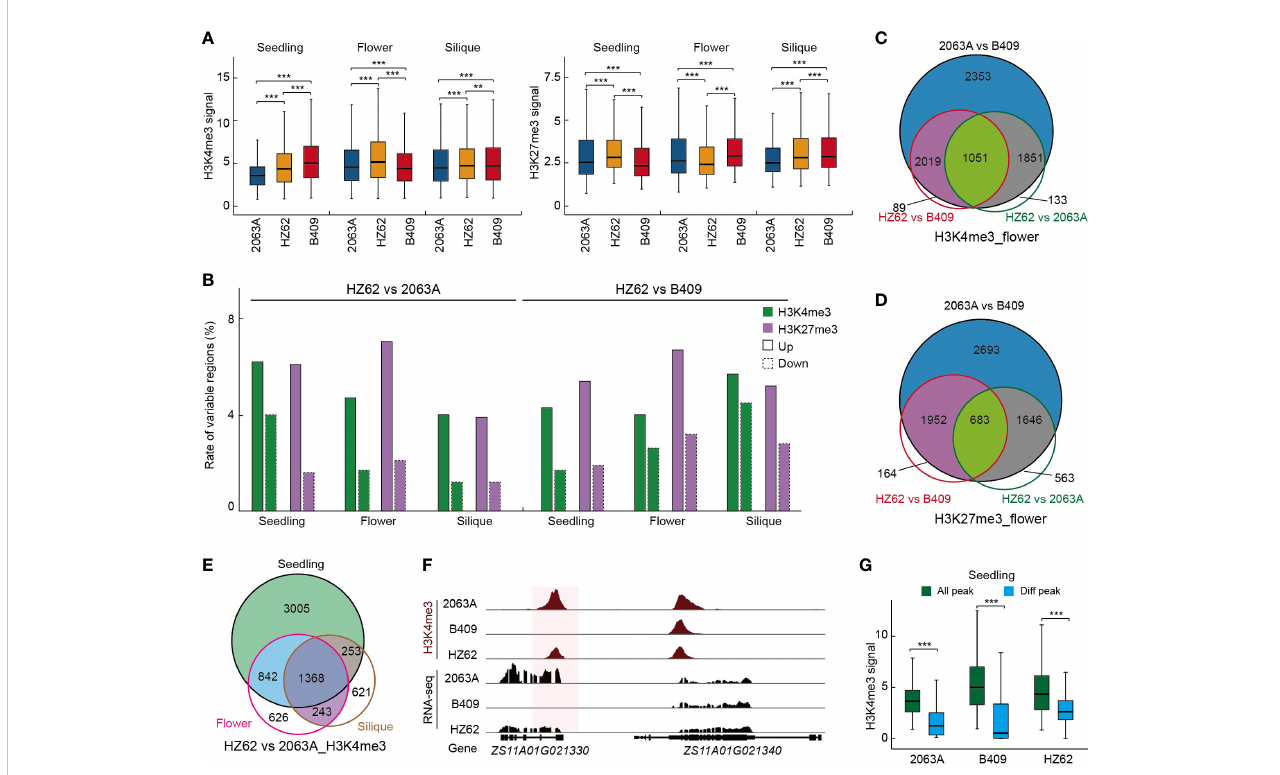
FIGURE 3 Epigenetic variations among hybrid and parents. (A) Peak intensities of histone modi fi cations in hybrid and parents in each tissue. *** p < 0.001 from Wilcoxon test. (B) The rate of variable H3K4me3 and H3K27me3 among hybrid and parents in the indicated tissues. (C) Overlap of H3K4me3 variation among parents and hybrid. (D) Overlap of H3K27me3 variation among parents and hybrid. (E) Overlap of H3K4me3 differences between hybrid and parents among three assessed tissues. (F) Example of differential histone modi fi cation regions in parental lines and hybrid. (G) H3K4me3 intensities of all H3K4me3 loci and variable H3K4me3 loci in the indicated varieties. *** p < 0.001 from Wilcoxon test. Asterisks indicate statistically signi fi cant